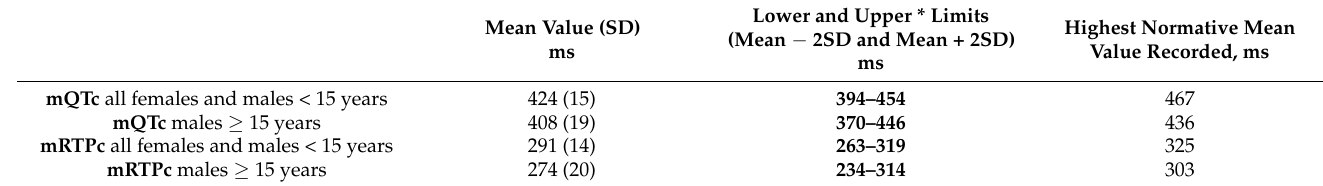
Table 2. Previously published normative Holter recording measurements [10]. The normative reference range is shown in bold in the third column. Noting that some normative values are higher than this, the highest values seen are in the fourth